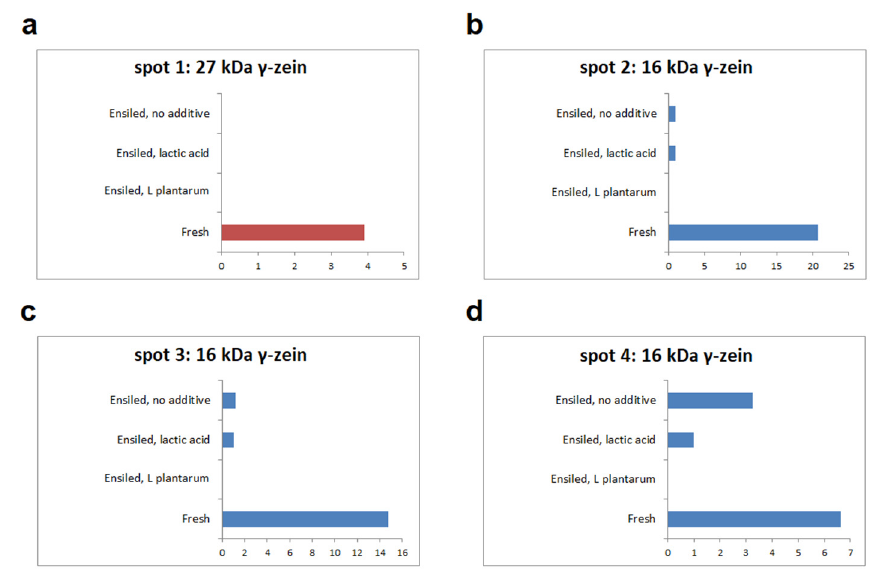
Figure 5. Evaluation of differences in detected γ -zein proteins. The proteins were analyzed with image analysis PDQuest 2-D software depending on the ensiling treatment: 27 kDa γ -zein spot 1 ( a ), 16 kDa γ -zein spot 2 ( b ), 16 kDa γ -zein spot 3 ( c ), and 16 kDa γ -zein spot 4 ( d ). The expression difference is statistically significant at p < 0.05 [34].